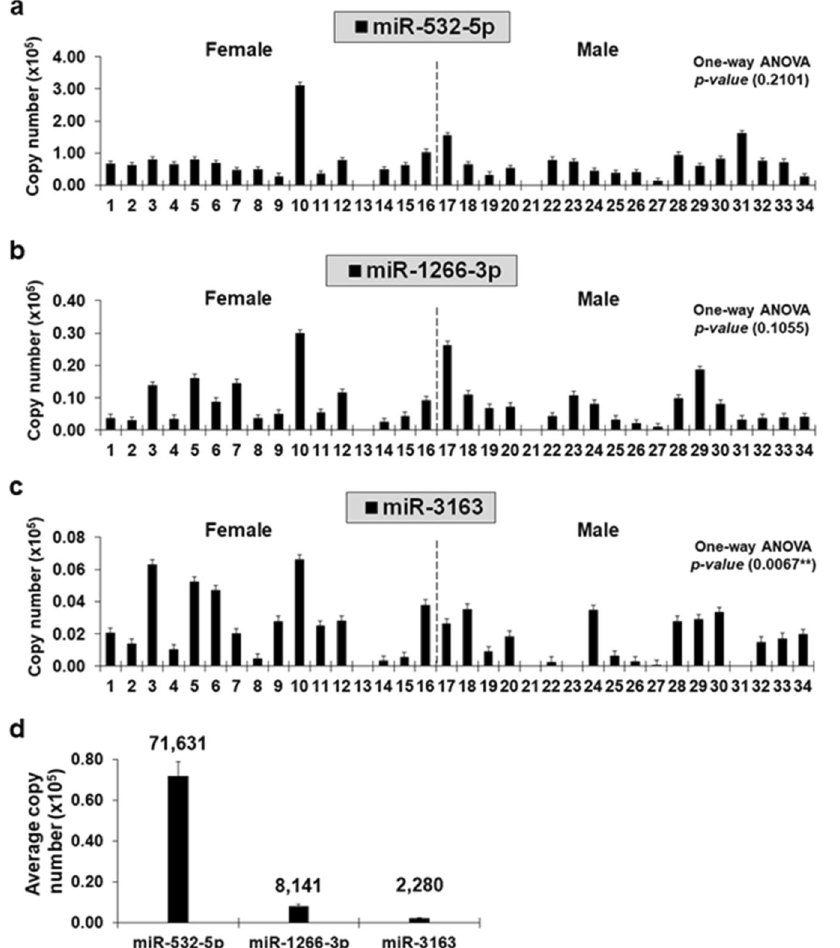
Fig. 6 MicroRNA copy numbers found in plasma from Stage I LUAD patients. a – c Copy numbers of miR-532-5p in ( a ), miR-1266-3p in ( b ), and miR-3163 in ( c ) obtained from absolute quanti fi cation using qRT-PCR analysis of plasma isolated at the time of surgical resection from early-stage female ( n = 16) and male ( n = 18) LUAD patients. x and y axes indicate patient IDs (female patients, 1 – 16, and male patients, 17 – 34) and measured copy numbers (×10 5 ), respectively. d Averaged copy number of miR-532-5p, miR-1266-3p, and miR-3163. A standard curve approach was applied to measure copy numbers by qRT-PCR analysis from three separate experiments conducted in duplicate, mean ± SEM; one-way ANOVA analysis, ** P <